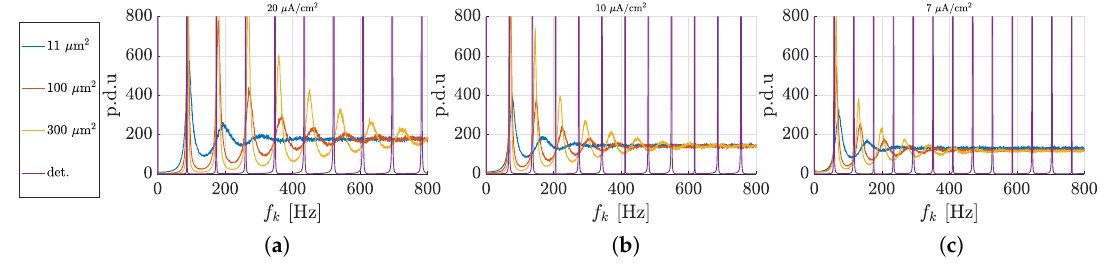
Figure 1. Power spectra for I 0 = (20, 10, 7) µA/cm 2 , and patch = (11, 100, 300) µm 2 .